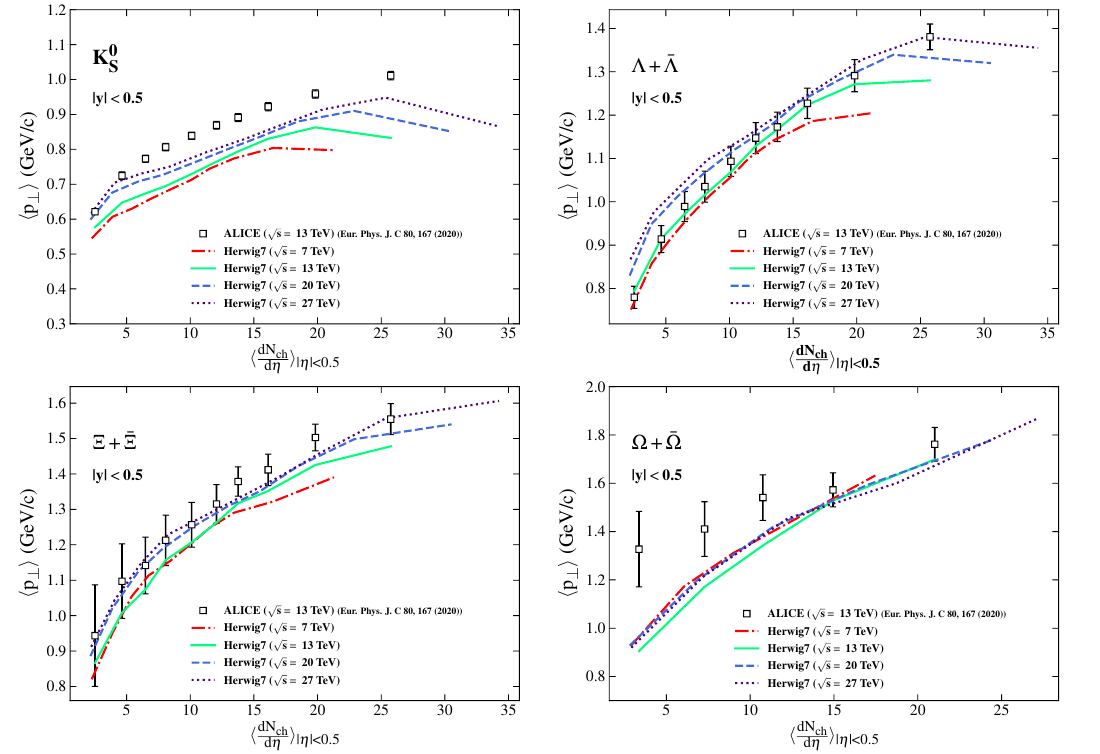
< 0.5 at √ s = 7 TeV, y | |